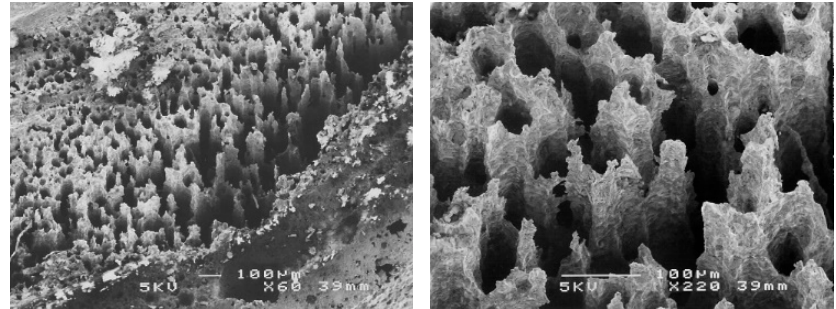
Figure 15. Scanning electron microscopy (SEM) of the transverse surface, corroded under a defective PTFE collar. The columnar morphology suggests preferential longitudinal dissolution due to the texture of the material.